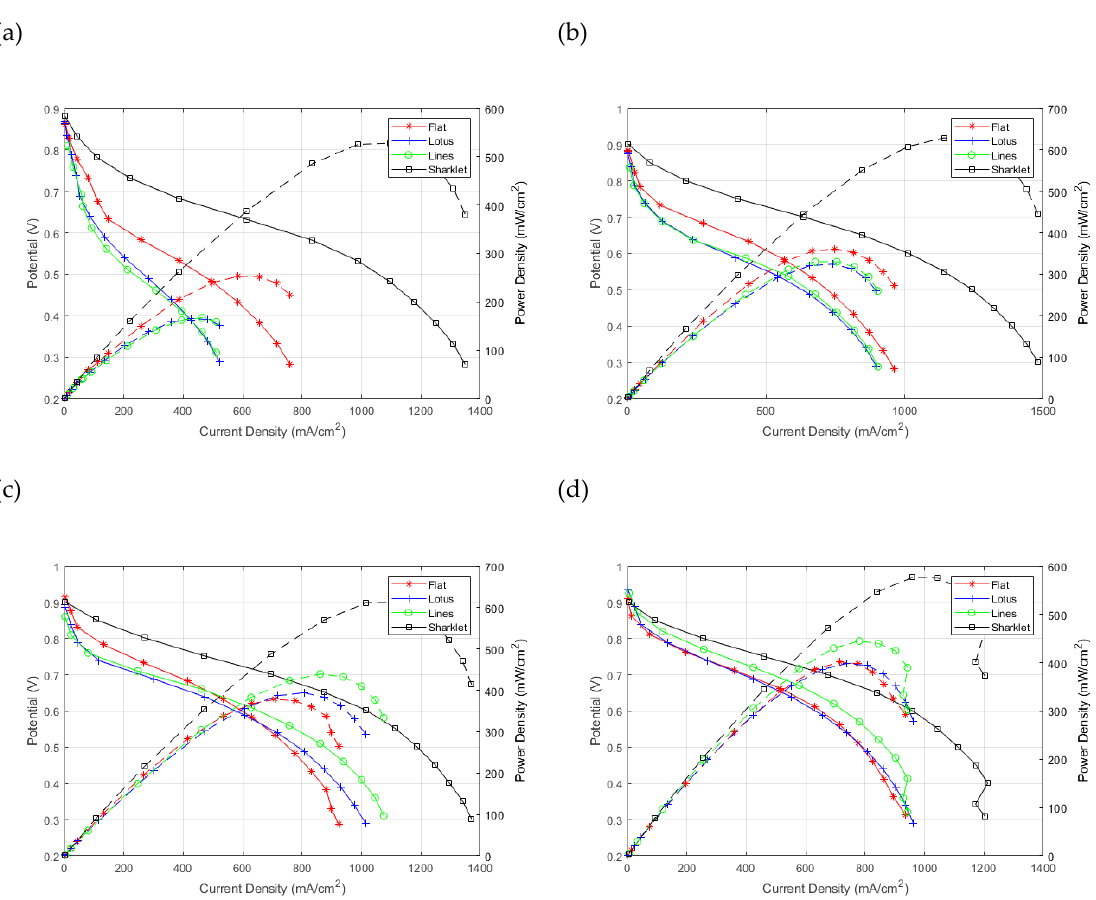
Figure 3. Fuel cell performance for the different membrane patterns at different hydration levels for ( a ) 25%, ( b ) 50%, ( c ) 75%, ( d ) 100%.